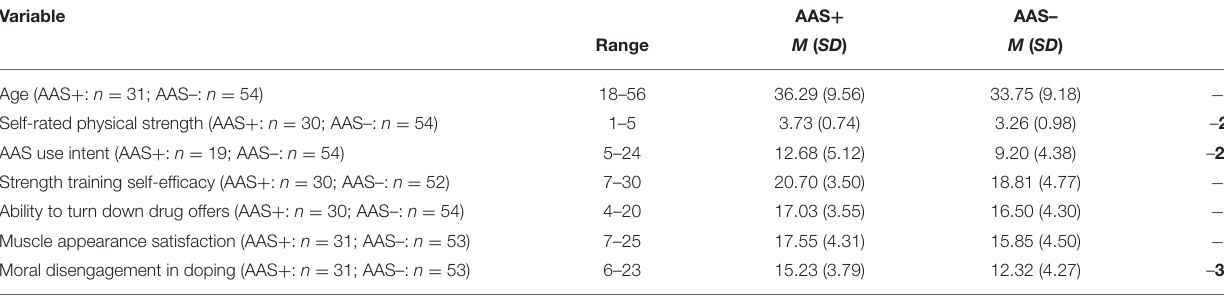
TABLE 4 | Baseline comparison of “lifetime” AAS-using (AAS + ) and non-using (AAS–) prisoners for the overall sample. Variable